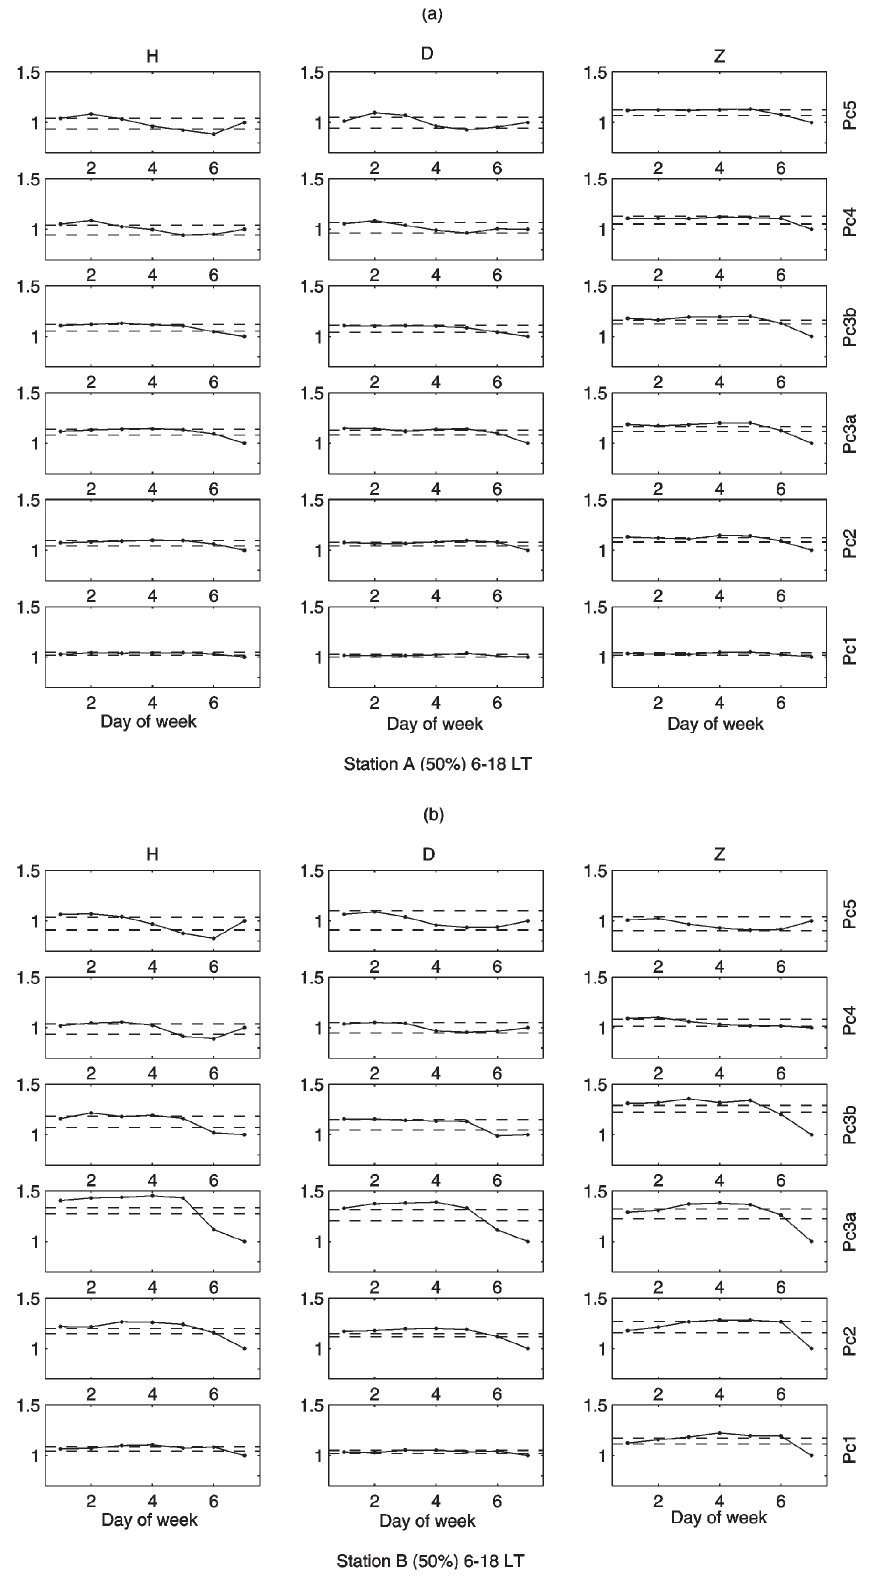
Fig. 2. Weekly variation of the daytime average power of magnetic field components in different frequency bands (50% of original spectra). Dashed lines identify the 99% confidence interval. (a) Station A. (b) Station